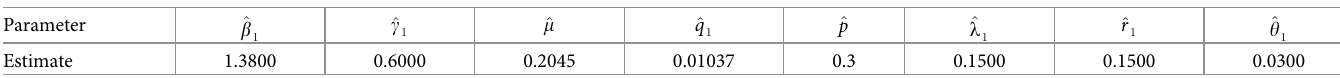
Table 4. Parameter estimates for model (35) with n =